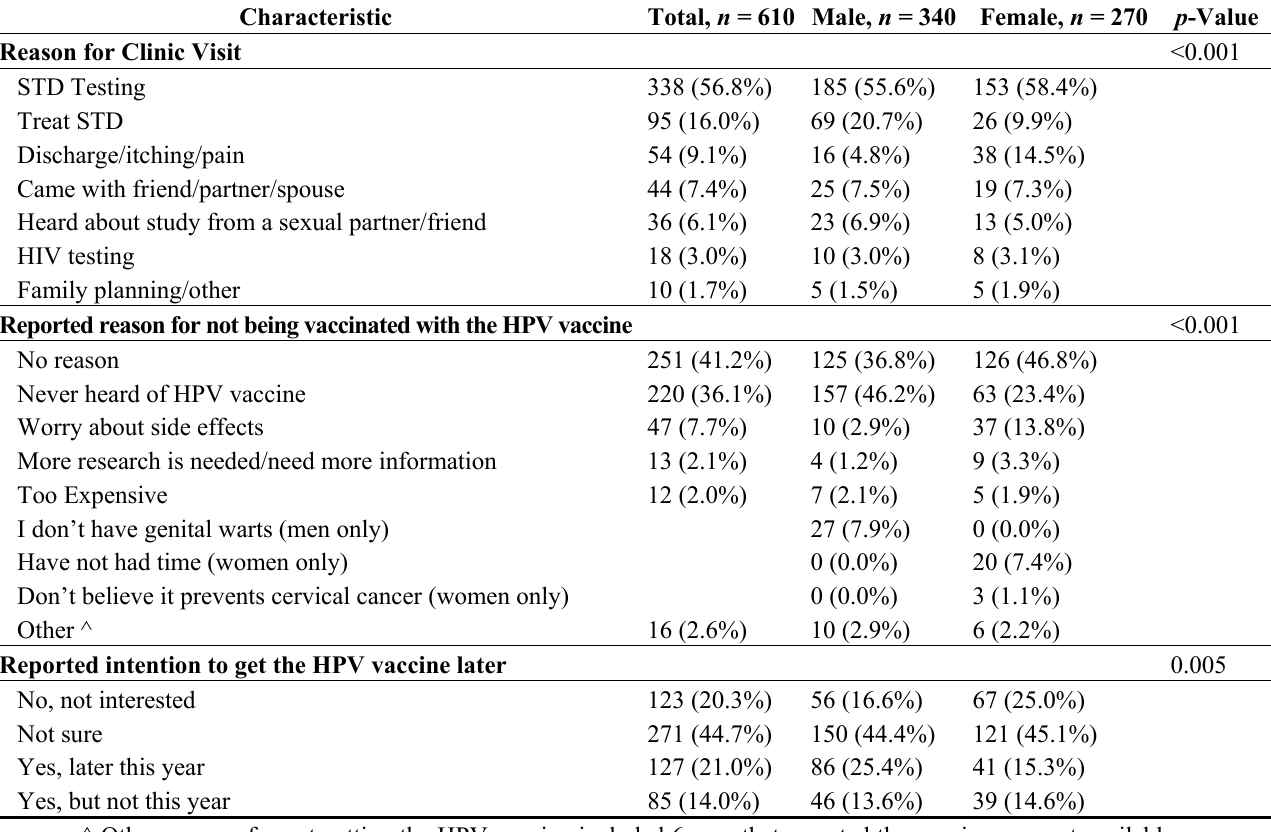
Table 2. Reasons reported at study baseline for: (i) visiting sexually transmitted disease (STD) clinic; (ii) deciding not to become vaccinated with the HPV vaccine; and (iii) intention to become vaccinated later, by